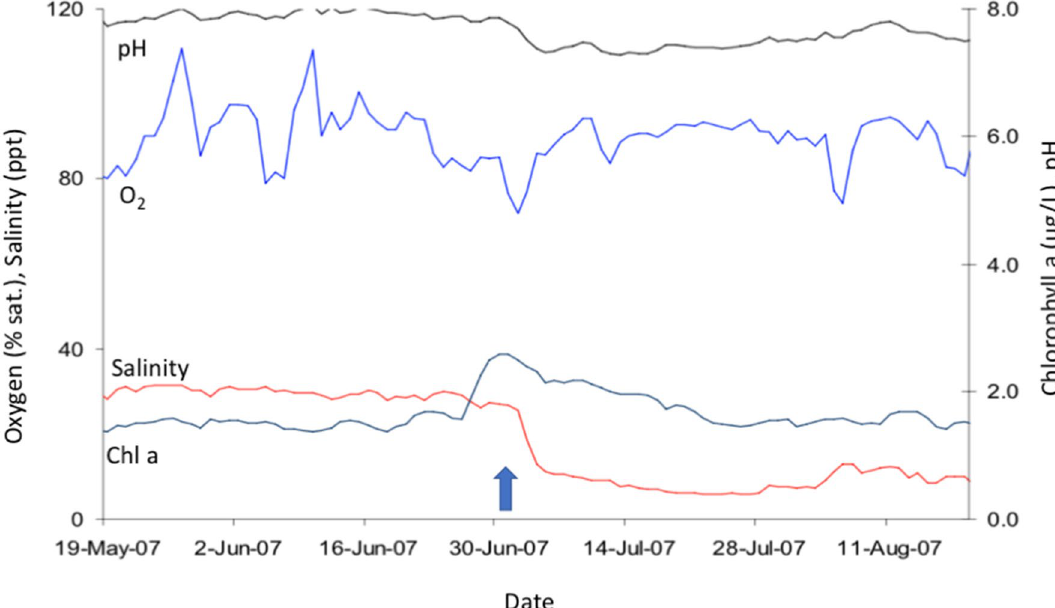
Figure 7. Water quality at McLennan’s Strait, Lake Victoria, showing the rapid decline in salinity (red line and arrow) in late June and sustained levels at 10 ppt or less through the period of monitoring at the end of August, 2007. Source 46